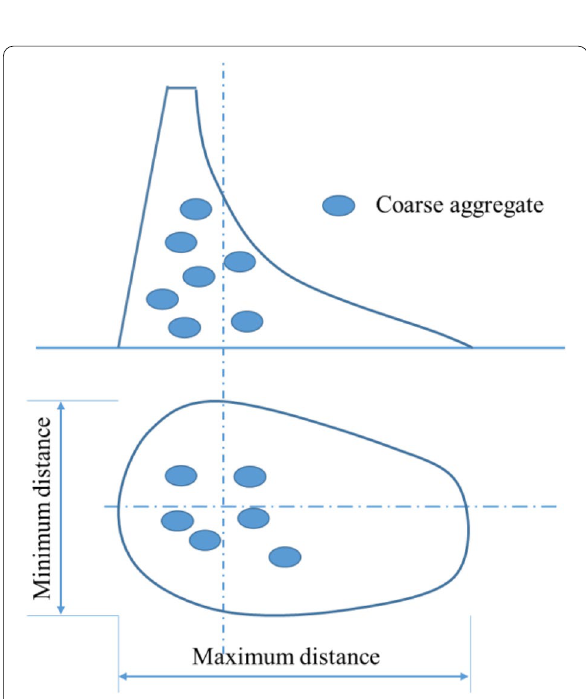
Fig. 3 Shapes of the collapsed